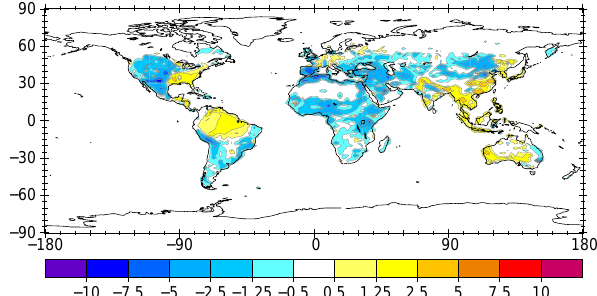
Fig. 12. Difference between YL95EMAC and Jaegl´e et al. (2005) (YL95EMAC – J05) (in ngm − 2 s − 1 ) for the year